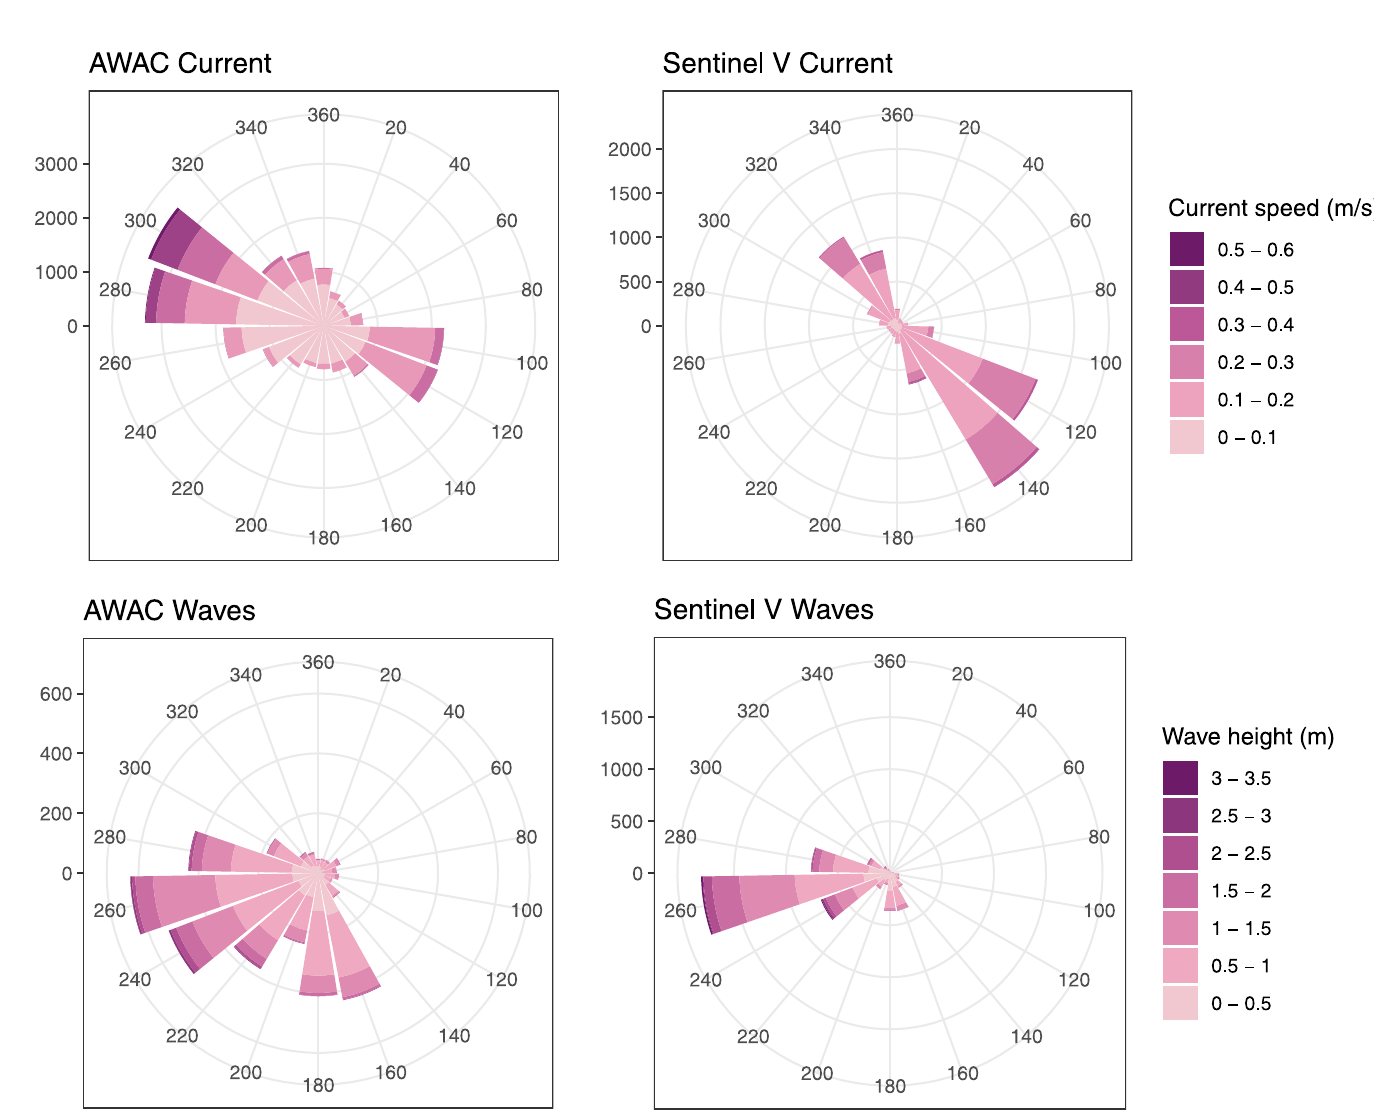
Fig 3. Current and wave directions from two current profilers. Wind roses of the currents and waves measured by the two profilers. Currents are towards the indicated directions, waves travel from the indicated directions.